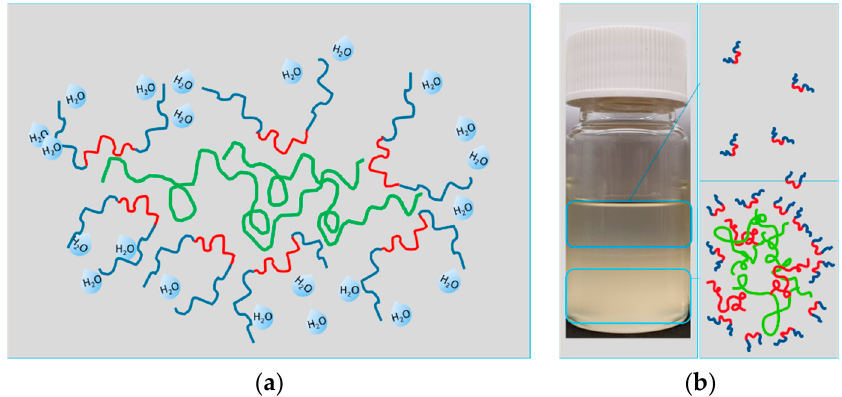
Figure 12. ( a ) Suggested agglomeration of PVP (green) in the inner and amphiphilic additives (red and blue) on the outer sphere. Here, a proposed state after cloud point measurements is illustrated. In ( b ) the macroscopic observed phase separation is sketched. Large molecules in red depict chains of PESU. All polymers are dissolved in a mixture of NMP, glycerol and water.